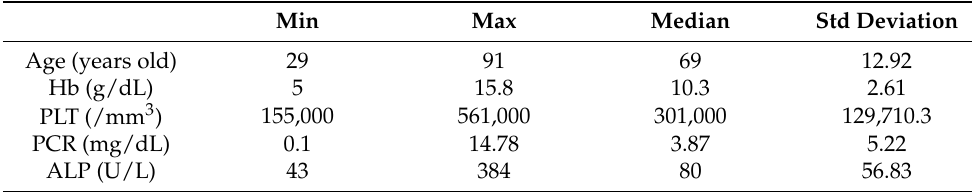
Table 2. Data analysis of patients with CRC.